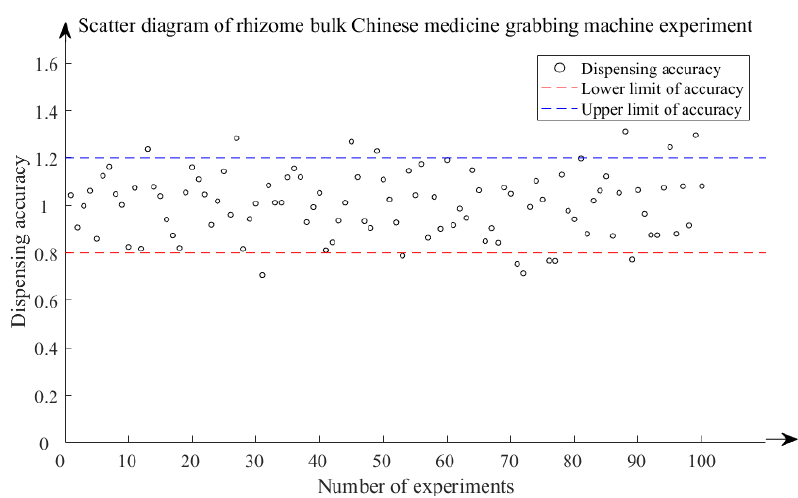
Figure A1. Scattered point diagram of adjustment accuracy.